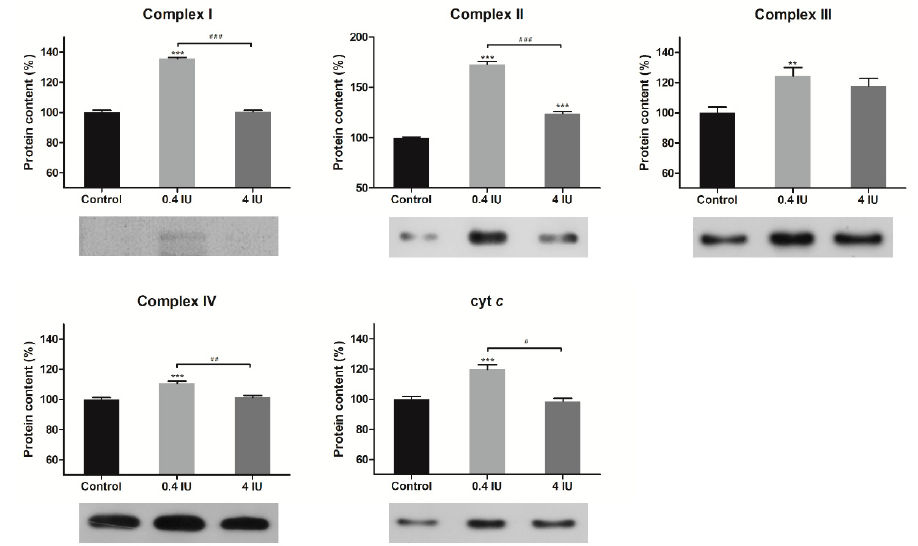
Figure 2. E ff ects of acute insulin treatment on the expression of electron transport chain (ETC) complexes and cyt c in mitochondria-enriched fractions (MEF). Protein content is expressed relative to controls, which were standardized to 100%. Mean ± SEM values are averages of three independent experiments performed in triplicate (pooled from six animals in each group). A representative blot is shown. Volume is the sum of all pixel intensities within a band (1 pixel = 0.007744 mm 2 ). * compared to control: ** p ≤ 0.01, *** p ≤ 0.001; # 0.4 IU vs. 4 IU: # p ≤ 0.05, ## p ≤ 0.01, ### p ≤ 0.001.